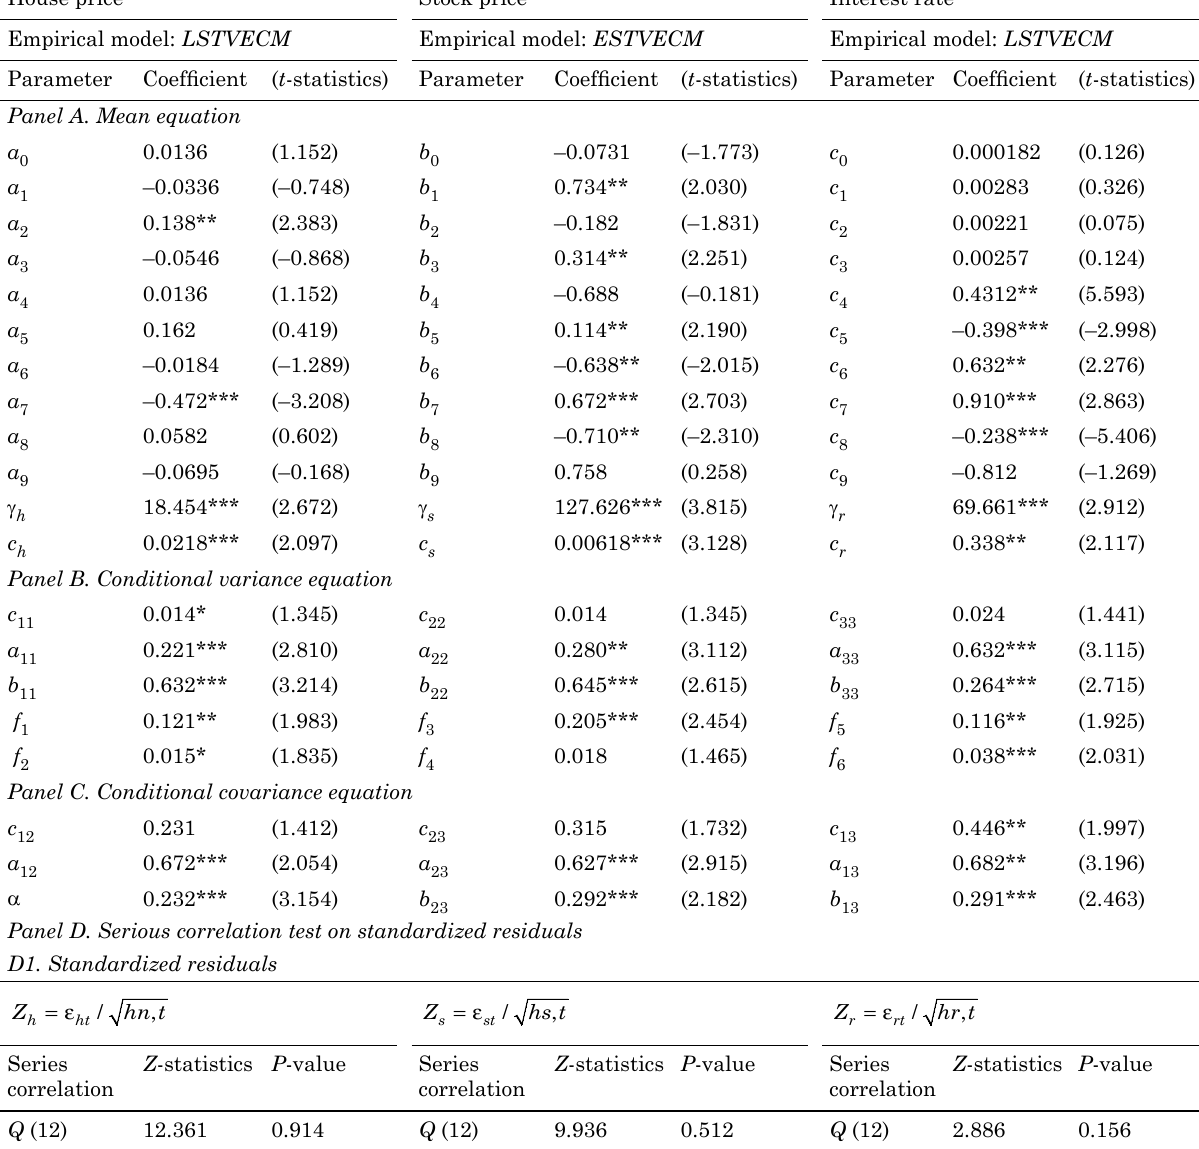
Table 9. Estimated result of STVEC-GARCH model: house price, stock price, and interest